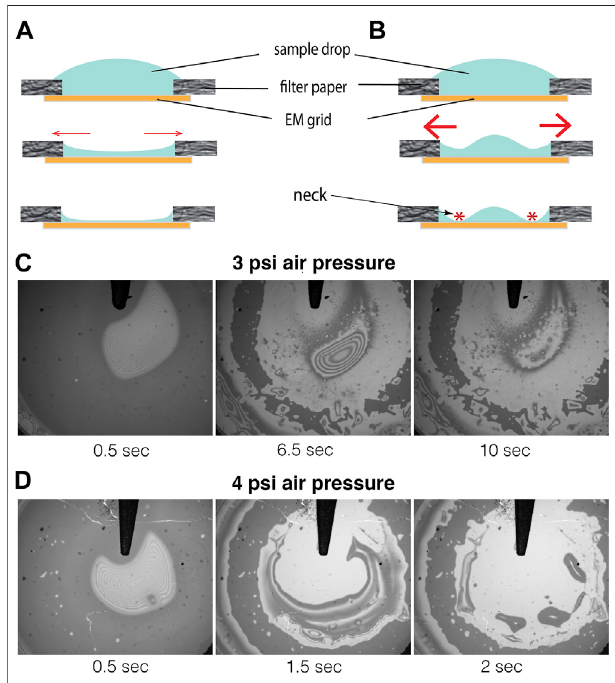
FIGURE 1 | Concept of, and preliminary results obtained by, axisymmetric draining of excess buffer from 3 mm coverslips. Panel A shows the desired, ideal outcome if excess buffer is removed adiabatically, indicated by thin red arrows. The sample is expected to become progressively thinner in the center, remaining thick only in the so-called Plateau border, closest to the edge of the fi lter paper. Panel B shows the expected, undesirable result that can occur if buffer is removed too quickly, indicated symbolically by thicker red arrows, thereby producing a thin neck that isolates a too-thick puddle that remains in the middle of the hole. Panels C and D show two example of preliminary re fl ection interference contrast microscopy (RICM) results obtained when a gentle stream of humid air was used as an additionaldrivingforcetomitigatetheproblemofnecking.Amottled,darkring remains after most of the buffer has been removed, which corresponds to the still-lubricated regions between the coverslip and the fi lter paper. Different valuesoftheairpressurewereempiricallyadjustedatthesourcetovaluesof3 psi in panel C and to 4 psi in panel D, respectively. The thickness of the buffer, if any,thatremains intheextensive,relatively brightareas mustbe signi fi cantly less than 100 nm, as is inferred from the absence of interference